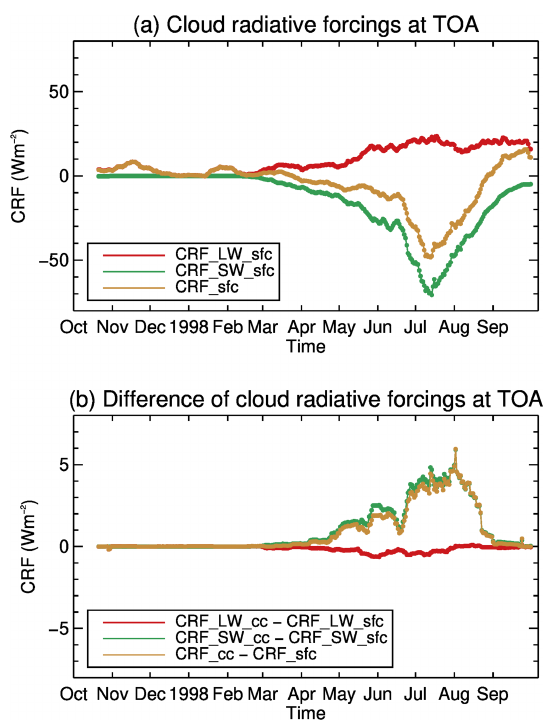
Figure 15. (a) CRF with a 20d running average of daily means at the TOA for LW and SW, with clouds from surface observations col- lected during the SHEBA experiment, and (b) CRF differences with clouds identified by the combined CloudSat and CALIPSO (CC) and all clouds from surface